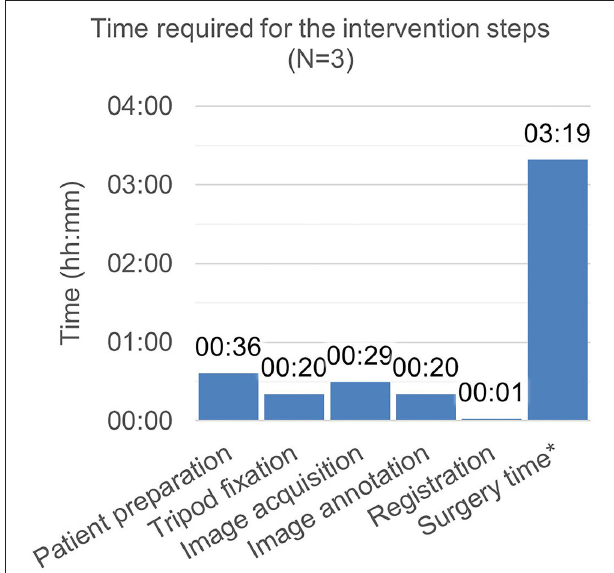
FIGURE 8 | Time required for the intervention steps. *Surgery time includes the non–study-related time during which period, the surgeon manipulates the patient. Time measurement was started with the incision and ended with the finished suture. It includes image annotation time (as the surgery was simultaneously continued). It excludes time required for image acquisition and export, as, during this period, the surgery was